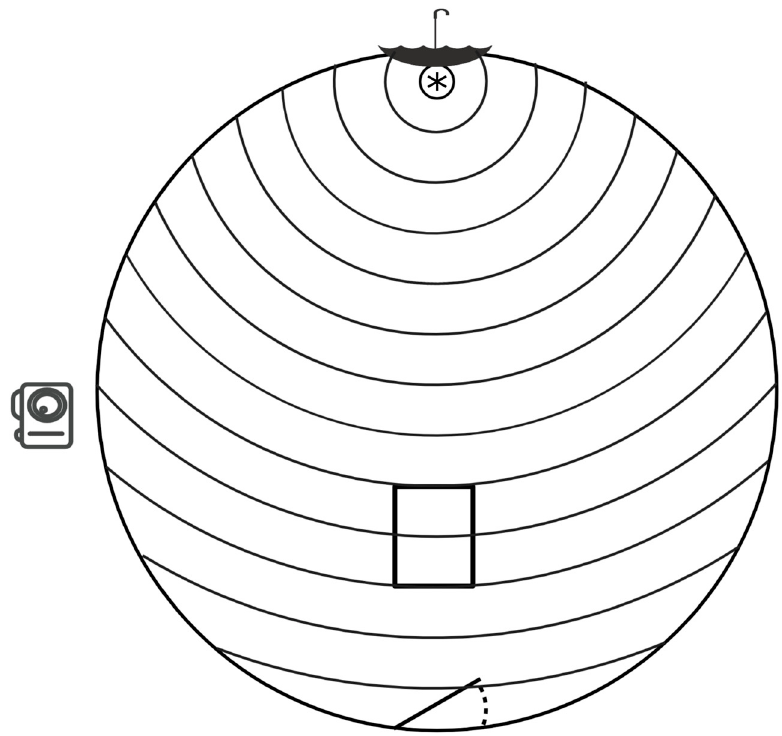
Figure 1. Diagram of test area layout, (not drawn to scale). Pan indicated by the asterisk in the pen diagram. Umbrella symbolized by an umbrella symbol. GoPro camera symbolized by a camera image. Line pointing upward to the right at the bottom of the figure with a dashed concave line symbolizes the entry and exit gate. Rectangle in center represents release point from handler at the beginning of test